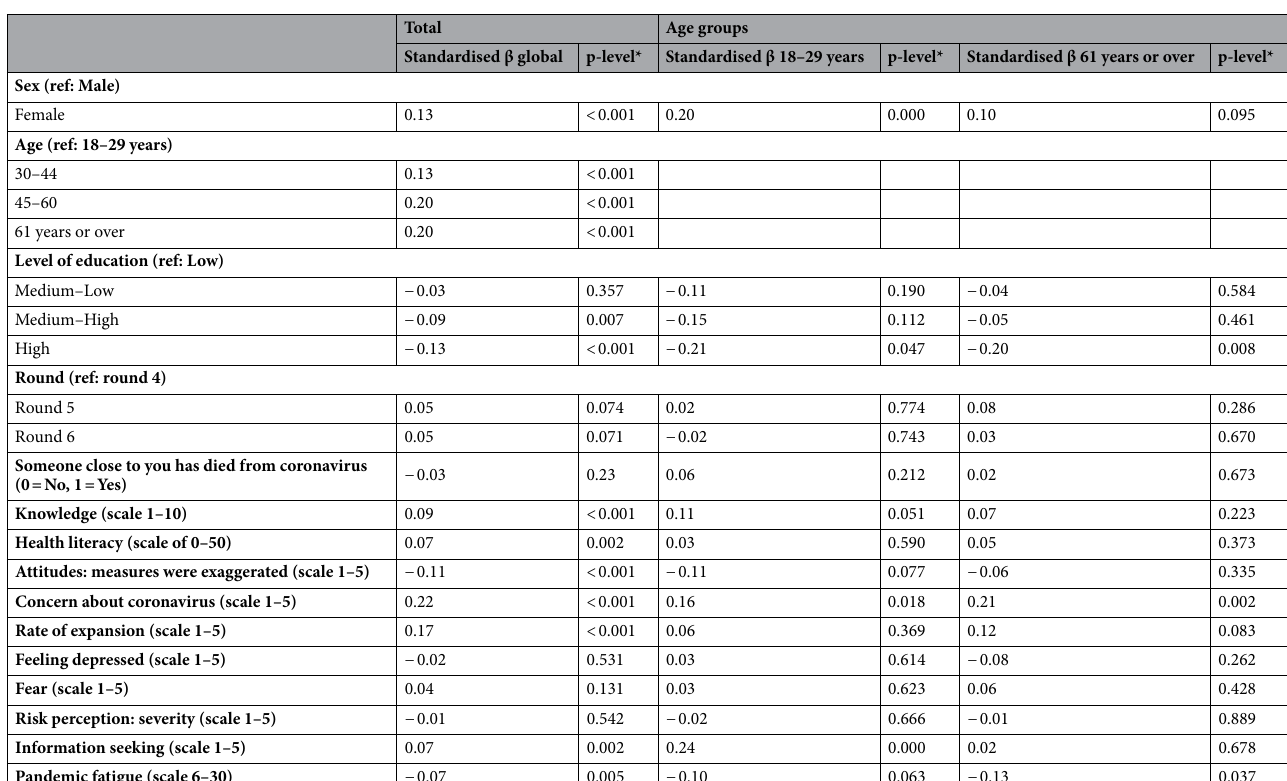
Table 5. Multiple linear regression with respect to preventive practices for total and by age groups. *All p-values are